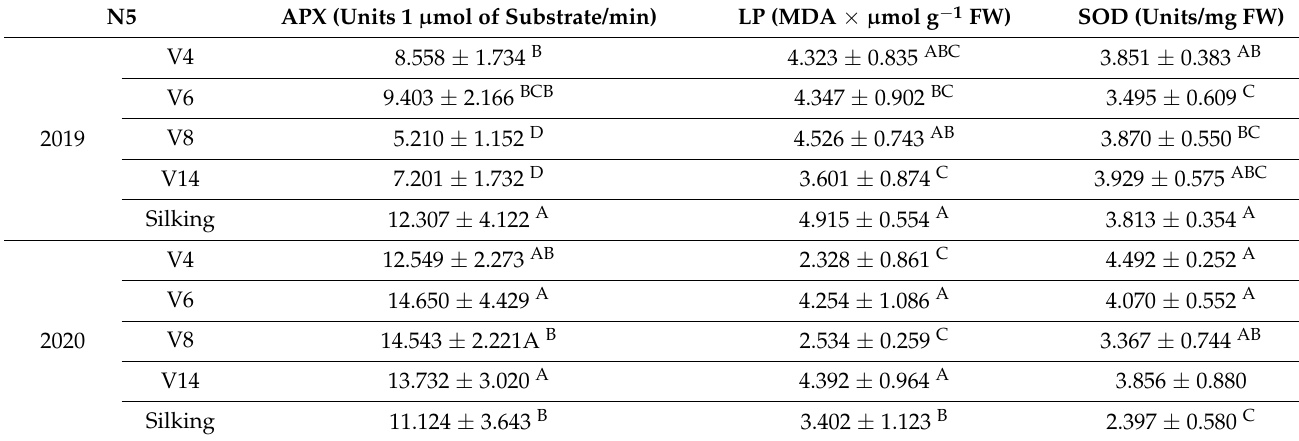
Table 3. Tukey pairwise comparisons the effect of the different sampling times and years for the APX: ascorbate peroxidase, SOD: superoxide dismutase activity and the LP: lipid peroxidation under 150 kg ha − 1 N fertilizer with an optimal ratio of phosphorus (P) and potassium (K). Treatments with the same letter are not significantly